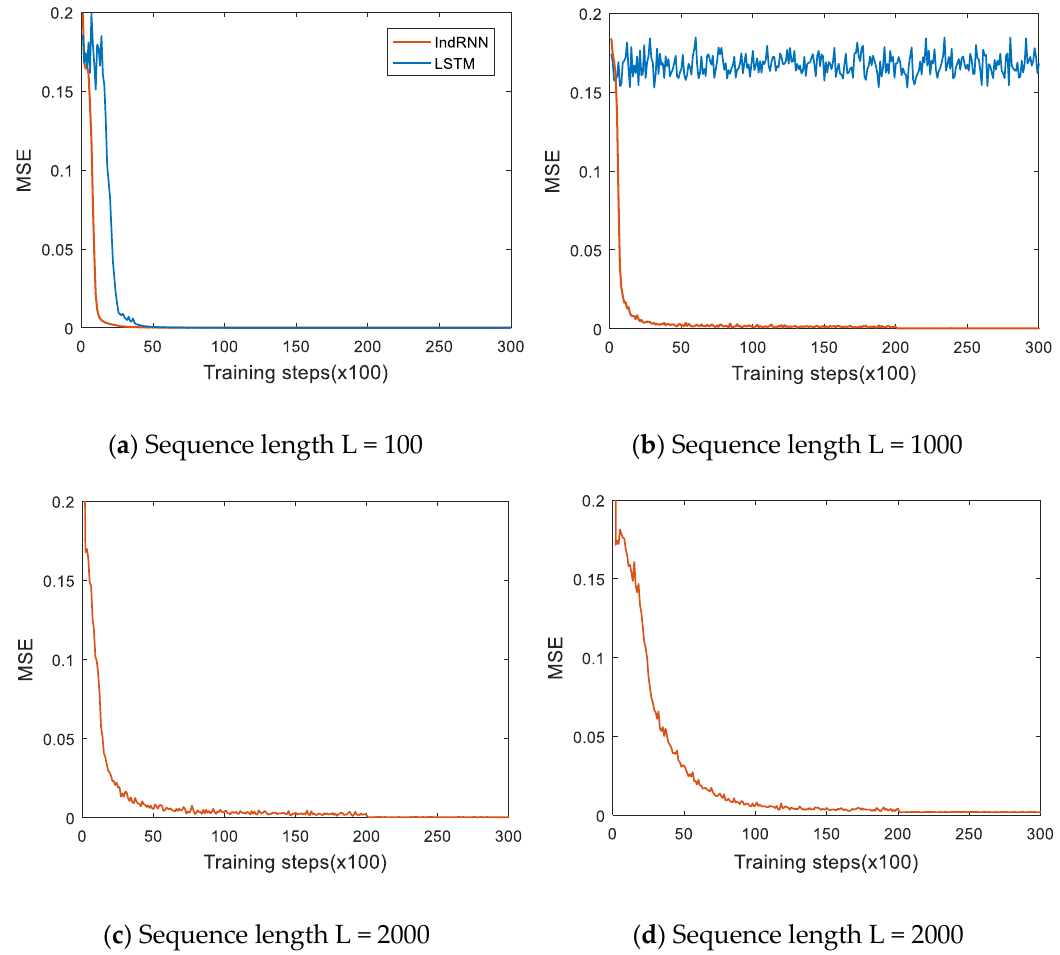
Figure 3. MSE of LSTM and IndRNN with different sequence lengths.